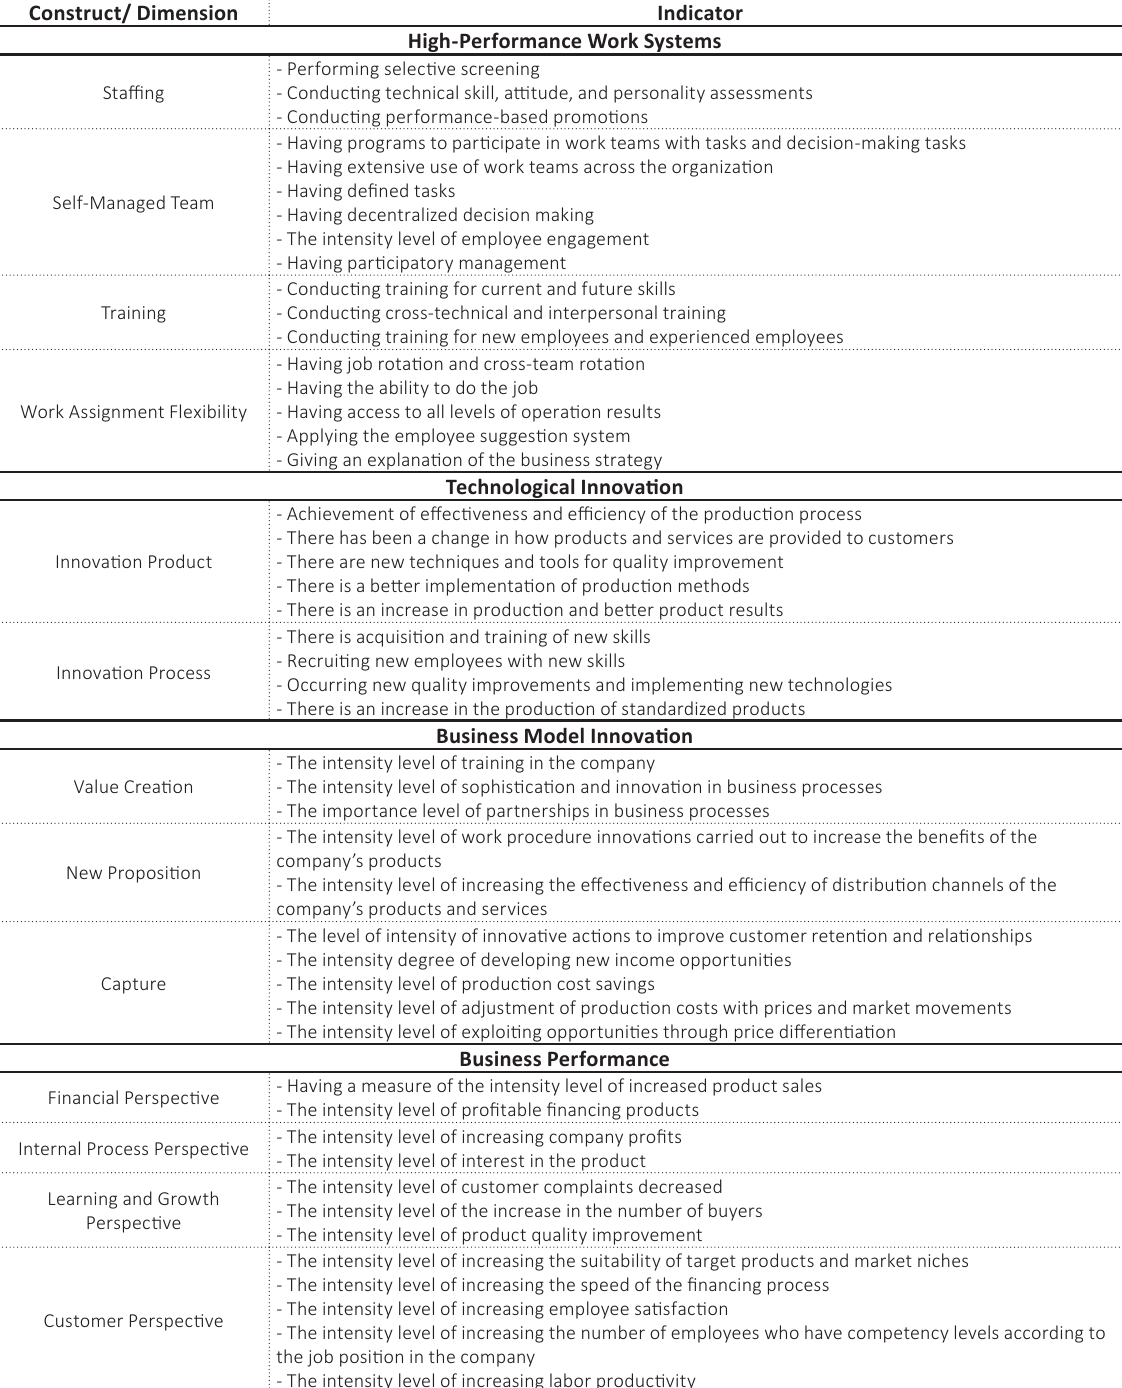
Table 2. Measurement items of the questionnaire used in this study Construct/ Dimension